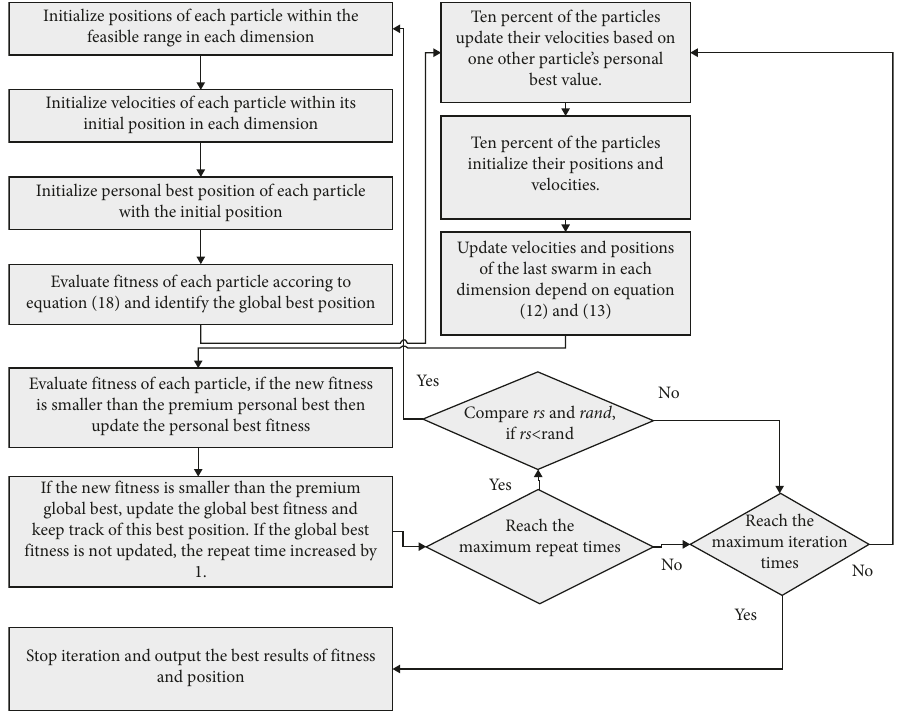
Figure 2: The flowchart of the proposed